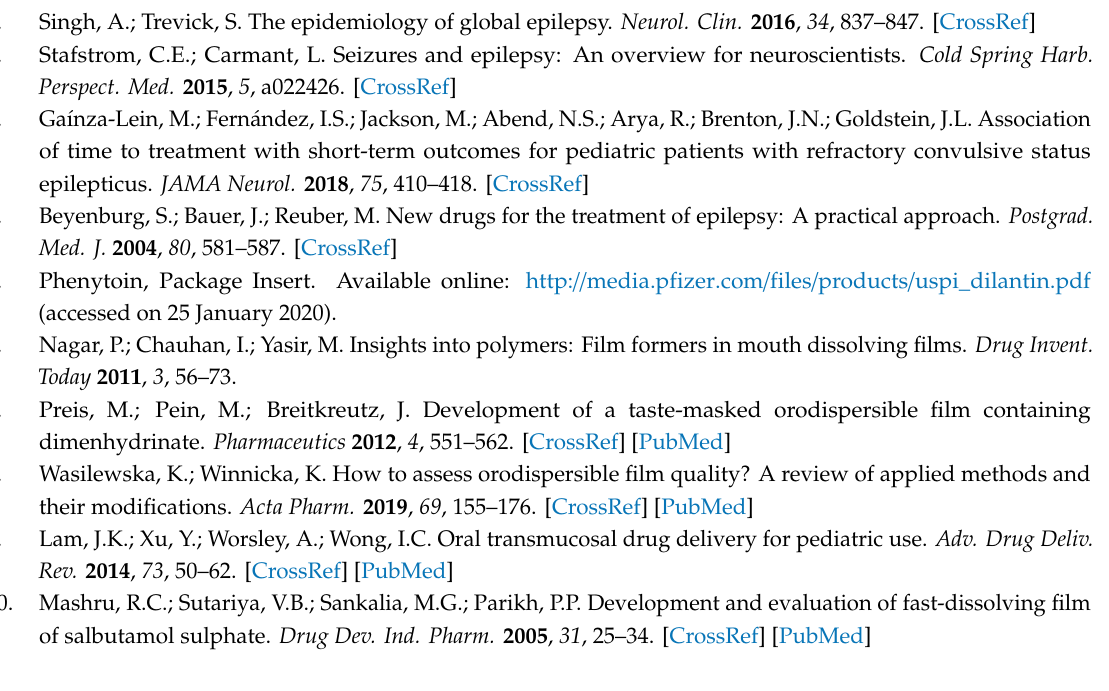
Figure S1: UV spectra of